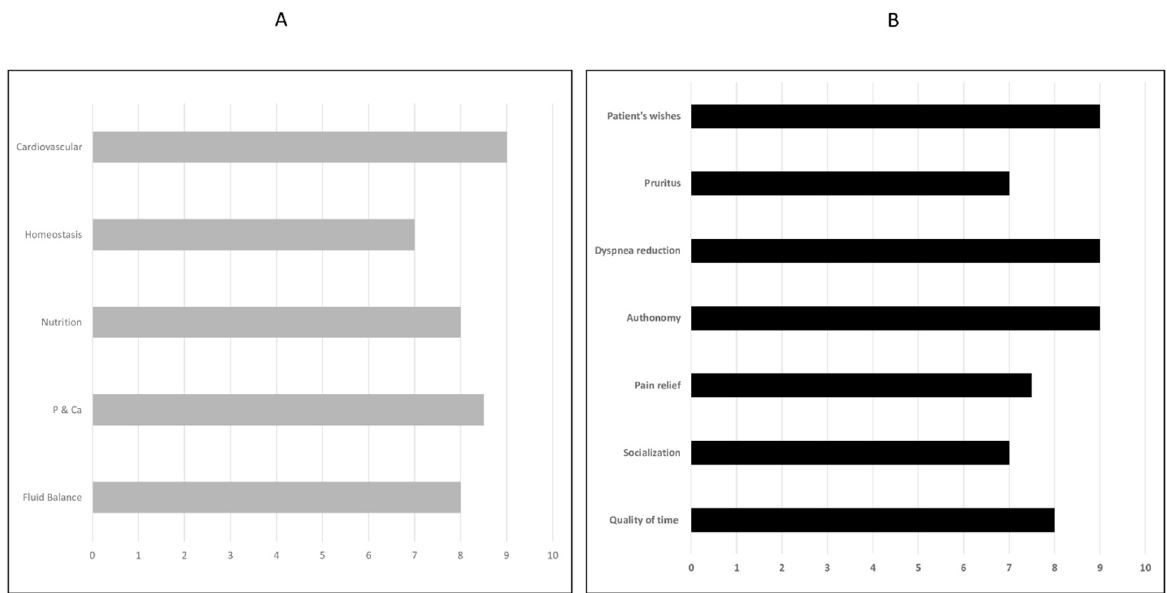
Figure 1. “Adequacy” of extracorporeal treatment and the role of palliative dialysis. Graph of a chronic extracorporeal renal substitution for CKD patient (panel A ) and graph of palliative dialysis for “CKD end-of-life” patient (panel B ). Each graph considers several variables differently affected by the treatments (0: the variable is minimally influenced; 10: the variable is strongly improved). The area may identify the adequacy of the treatment within the graph: during an ideal therapy, the inner area covers 100% of the graph. For a treatment to be “adequate”, other parameters than solute clearance or fluid balances should be considered for end-of-life patients; in this scenario, an individualized RRT prescription should improve the physical, emotive, and autonomy-related